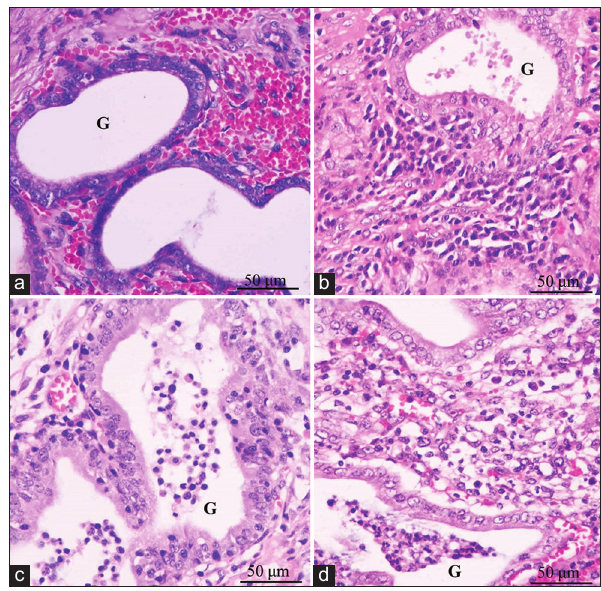
Figure-1: Hematoxylin and eosin-stained histological images of transverse uterine horn fragment showing endometrial layer of uterus, with uterine gland (G). Histopathological classification into uncomplicated cystic endometrial hyperplasia (CEH) (a), CEH and plasma cell infiltrated (b), CEH and acute endometritis (c), and CEH and chronic endometritis (d), with all